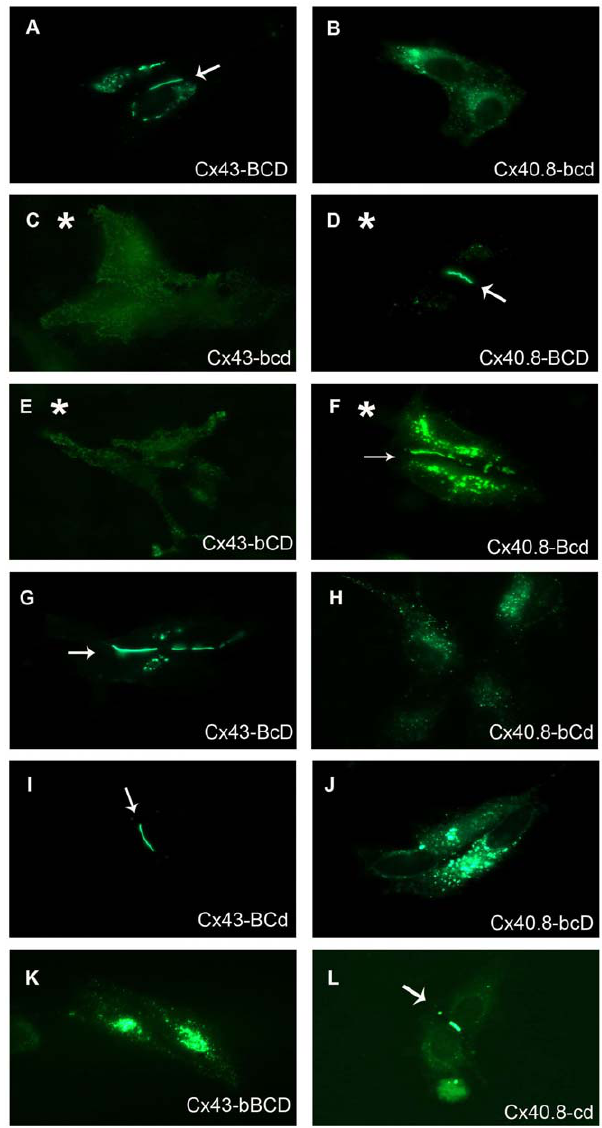
Figure 5. The Cx40.8-b domain is responsible for the intracel- lular localization of Cx40.8. HeLa cells were singly transfected with EGFP fusions of each construct. (A) Cx43-BCD-EGFP, (B) Cx40.8-bcd- EGFP, (C) Cx43-bcd-EGFP, (D) Cx40.8-BCD-EGFP, (E) Cx43-bCD-EGFP, (F) Cx40.8-Bcd-EGFP, (G) Cx43-BcD-EGFP, (H) Cx40.8-bCd-EGFP, (I) Cx43- BCd-EGFP, (J) Cx40.8-bcD-EGFP, (K) Cx43-bBCD-EGFP, (L) Cx40.8-cd- EGFP. Asterisks denote constructs in which the localization depends on a component of the carboxy terminus. Arrows identify gap junction plaques.